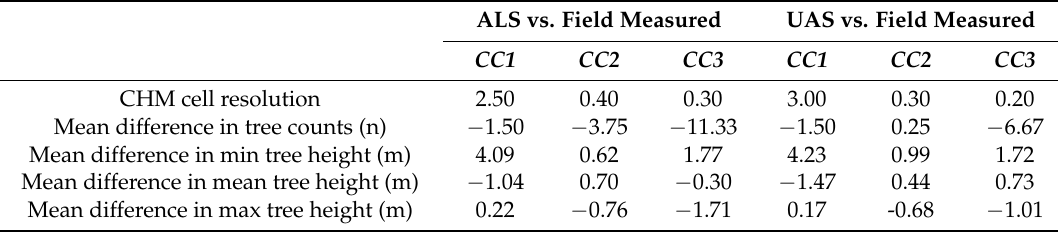
Table 4. Differences in optimized cell resolutions and plot composite summaries of remote sensing methods compared to in situ measurements. CC1 describes plots that had 10–40% canopy cover; CC2 plots had 40–70% canopy cover; and CC3 plots had 70–100% canopy cover. ALS vs. Field Measured UAS vs. Field